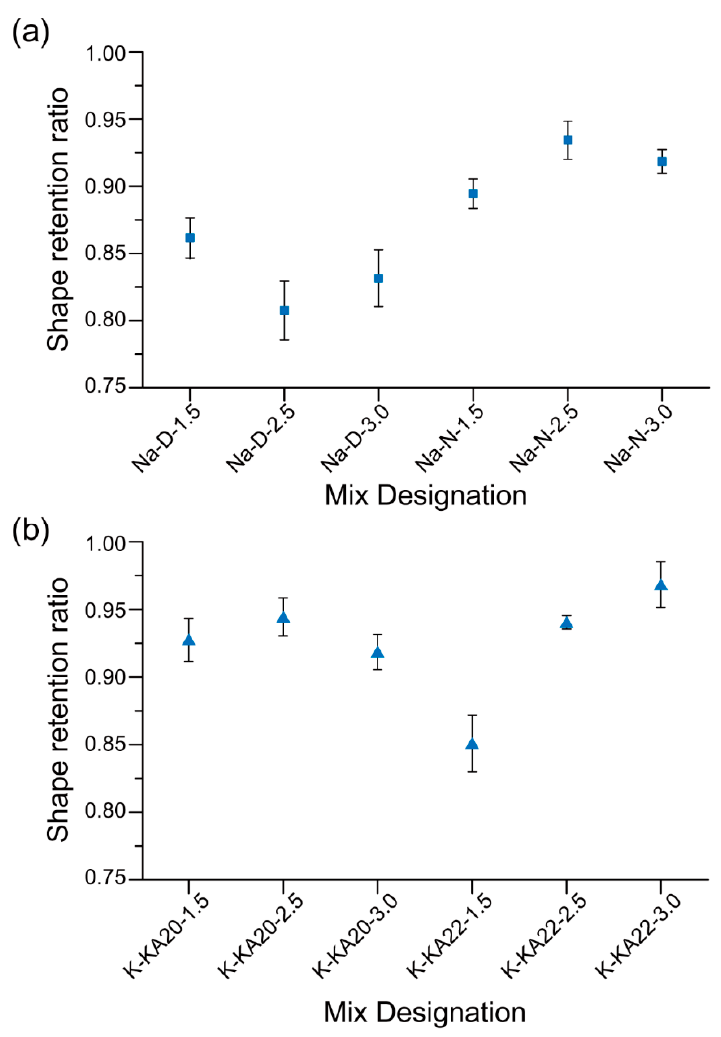
Figure 9. Shape retention ratios of 3D printable geopolymers with ( a ) Na-based activators and ( b ) K-based activators.